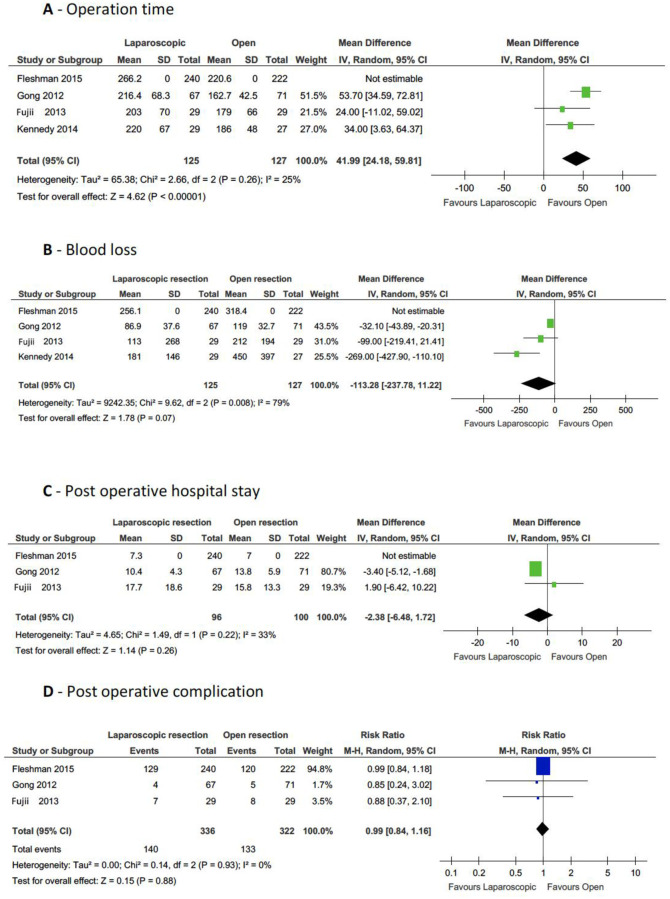
Forest plot of peri-operative and clinical outcomes.